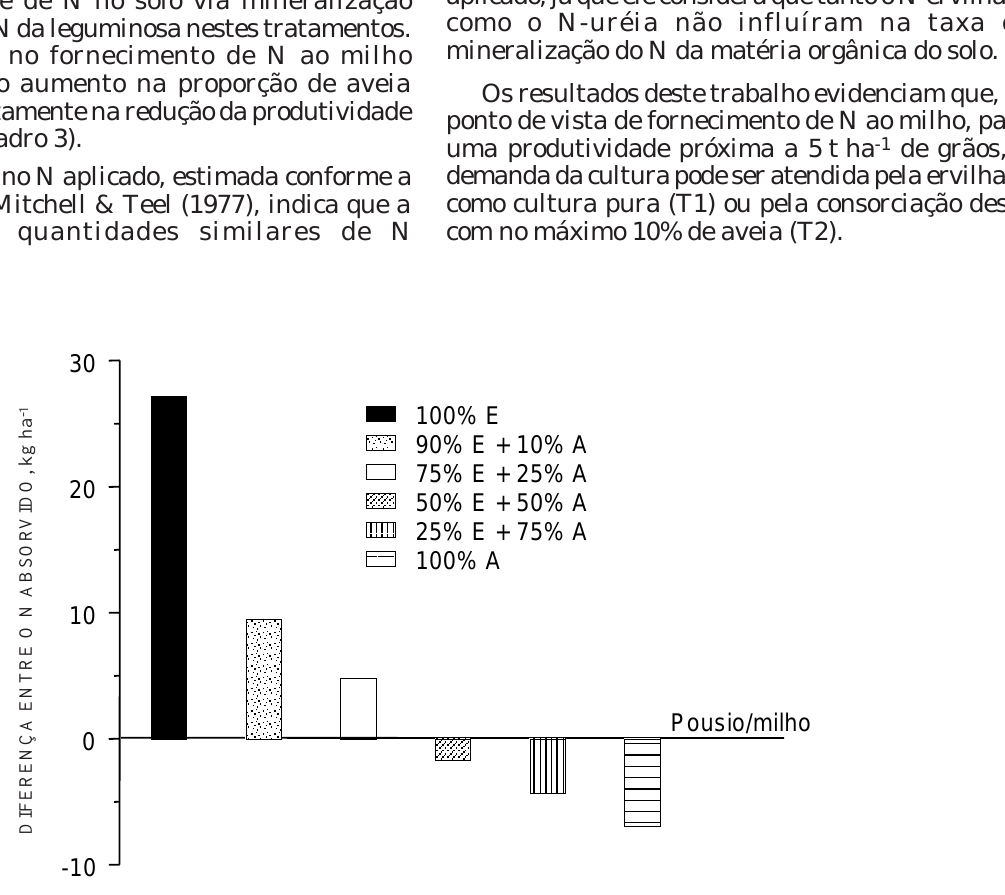
Figura 3. Fornecimento de N ao milho pela ervilhaca (E) e aveia (A), obtido pela diferença entre as quantidades de N acumulado pelo milho nos diferentes tratamentos e no pousio.